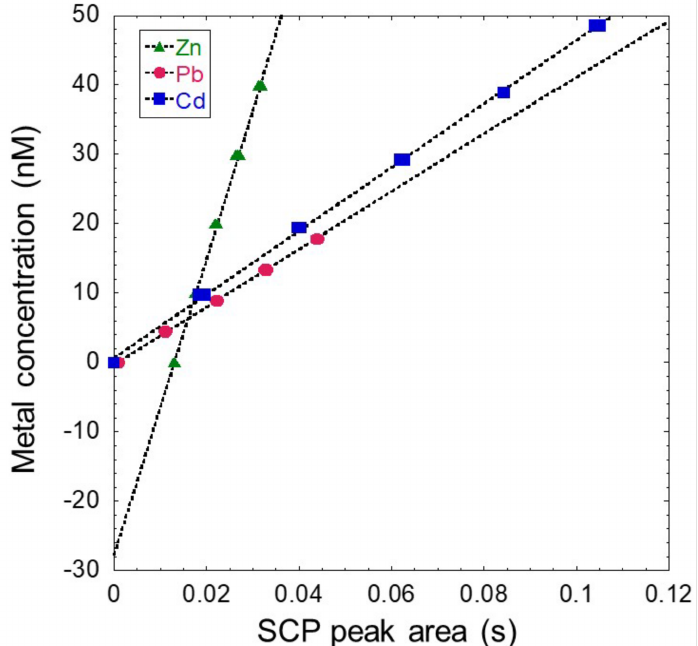
Figure 3. Reversed-axis standard addition method for the unfiltered river sample (Aub 19.12.04), using a t d of 90 s and deposition potential ( E d ) of − 1.25 V at pH 3.5 for Cd(II), Pb(II) (Table 6) and Zn(II) (Table